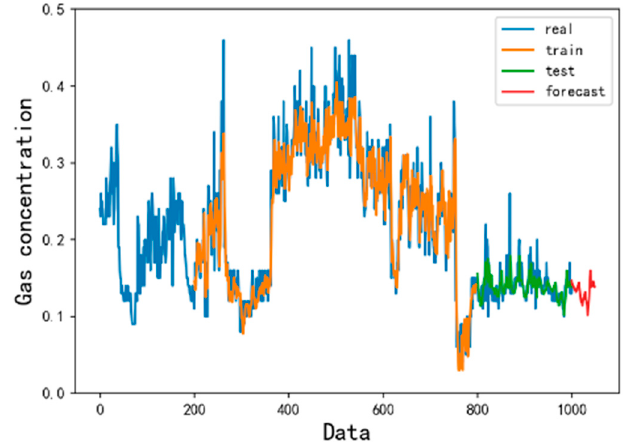
Figure 14. LSTM prediction model fitting effect diagram.